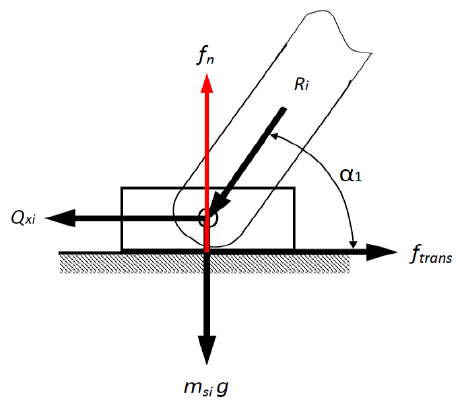
Figure 5. Free-body diagram at the slider i , including the translational friction f trans .